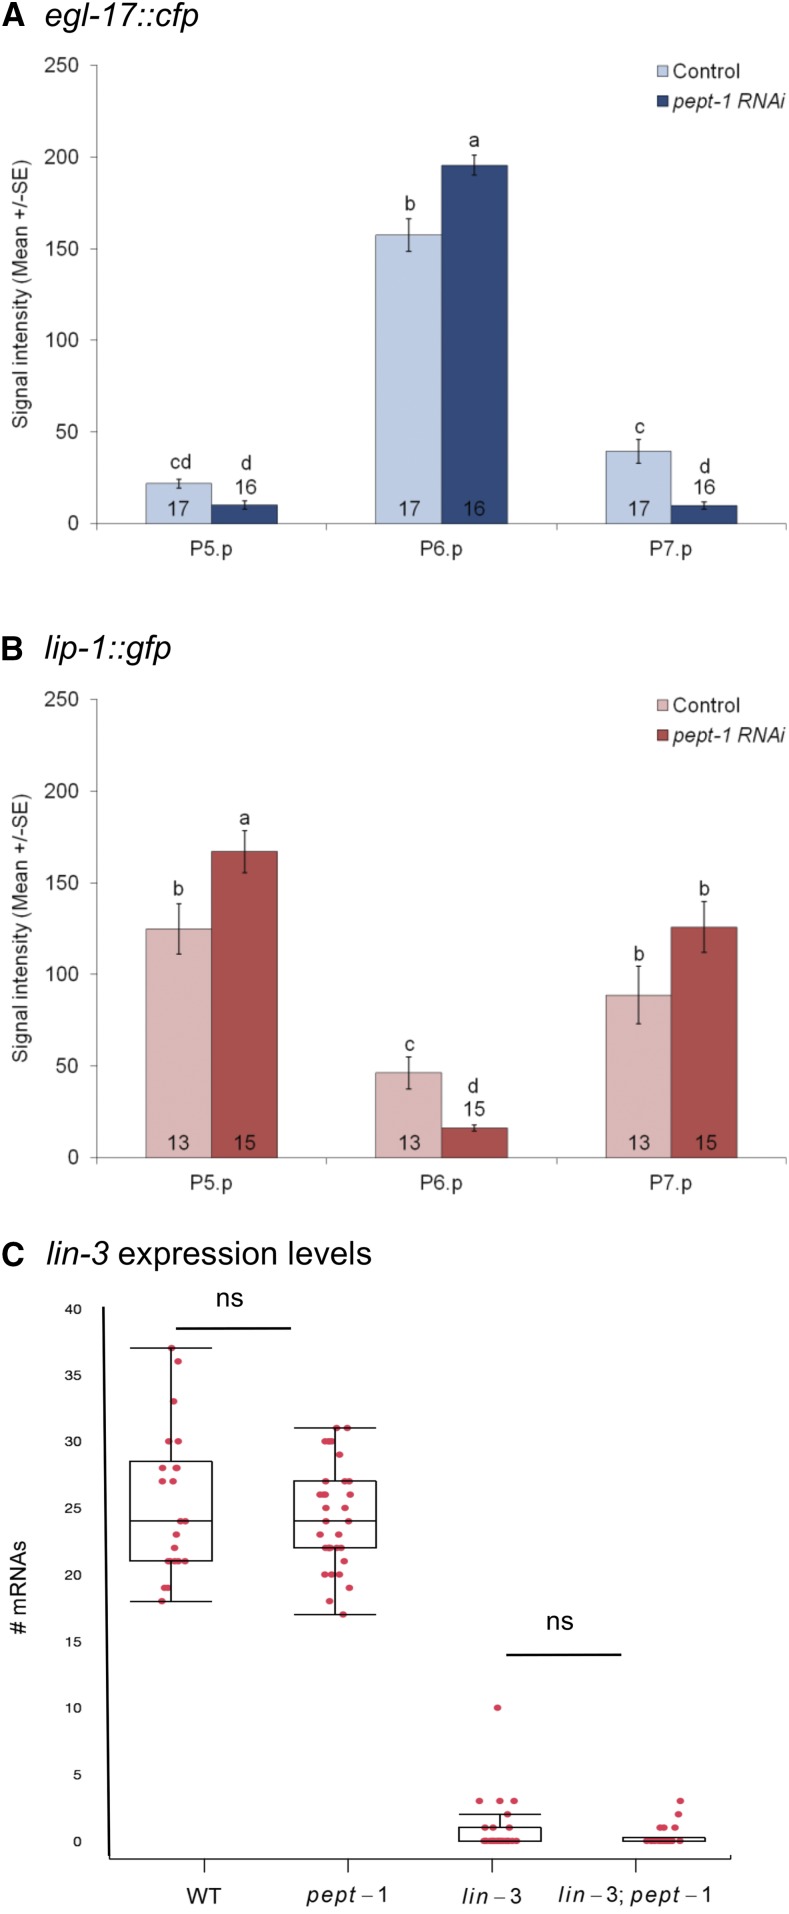
Reduced activity of PEPT-1 increases Ras and Notch pathway activities but does not alter lin-3 transcript levels. (A,B) Effects of pept-1 RNAi on the level of the transcriptional reporters egl-17::cfp (EGF-Ras-MAPK activity) (Yoo et al. 2004) and lip-1::gfp (Delta-Notch activity) (Berset et al. 2001) quantified in lethargus L2/L3 and early L3 stages. (A) Mean signal (pixel) intensity of the EGF-Ras-MAPK pathway reporter, egl-17::cfp in P5.p to P7.p. Values indicate Least Square Means for the interaction cell x RNAi treatment (F2,62 = 15.52, P < 0.0001) (Table 2A). (B) Mean signal (pixel) intensity of the Delta-Notch pathway reporter, lip-1::gfp in P5.p to P7.p. Values indicate Least Square Means for the interaction cell x RNAi treatment (F2,52 = 13.73, P < 0.0001) (Table 2B). For complete statistical analysis and results, see Table 2. Values with different letters indicate significant differences (Tukey’s HSD). Numbers displayed in bars represent the number of individuals scored; error bars indicate ± 1 SEM (C) Boxplot showing lin-3 mRNA levels in different genetic backgrounds [wild type, pept-1(lg601), lin-3(e1417) and lin-3(e1417); pept-1(lg601)] is displayed. The pept-1 mutation does not alter the lin-3 expression level (mean = 24.38 ± 0.67; n = 34) compared to the wild type (mean = 25.36 ± 0.35; n = 22) (ANOVA, F1,54 = 0.49, P = 0.49). As expected, there is little expression in lin-3(e1417) mutant animals (Mean: 0.77 ± 0.35, n = 31) but this low expression is not rescued in lin-3; pept-1 double mutant animals (Mean: 0.36 ± 0.17; n = 22) (ANOVA, F1,751= 0.46, P = 0.50).